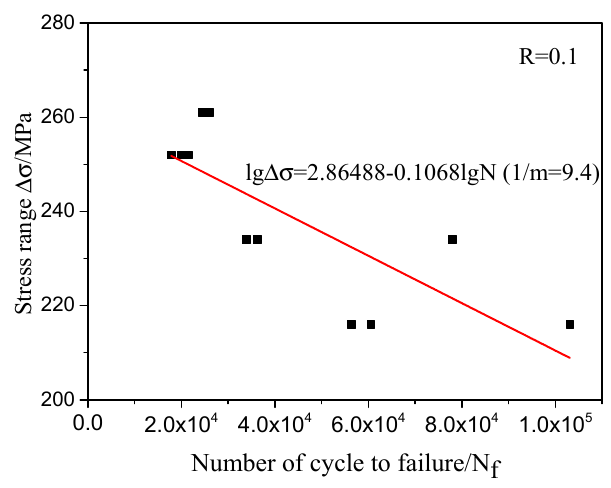
Figure 3. S-N curve of FSW specimens.